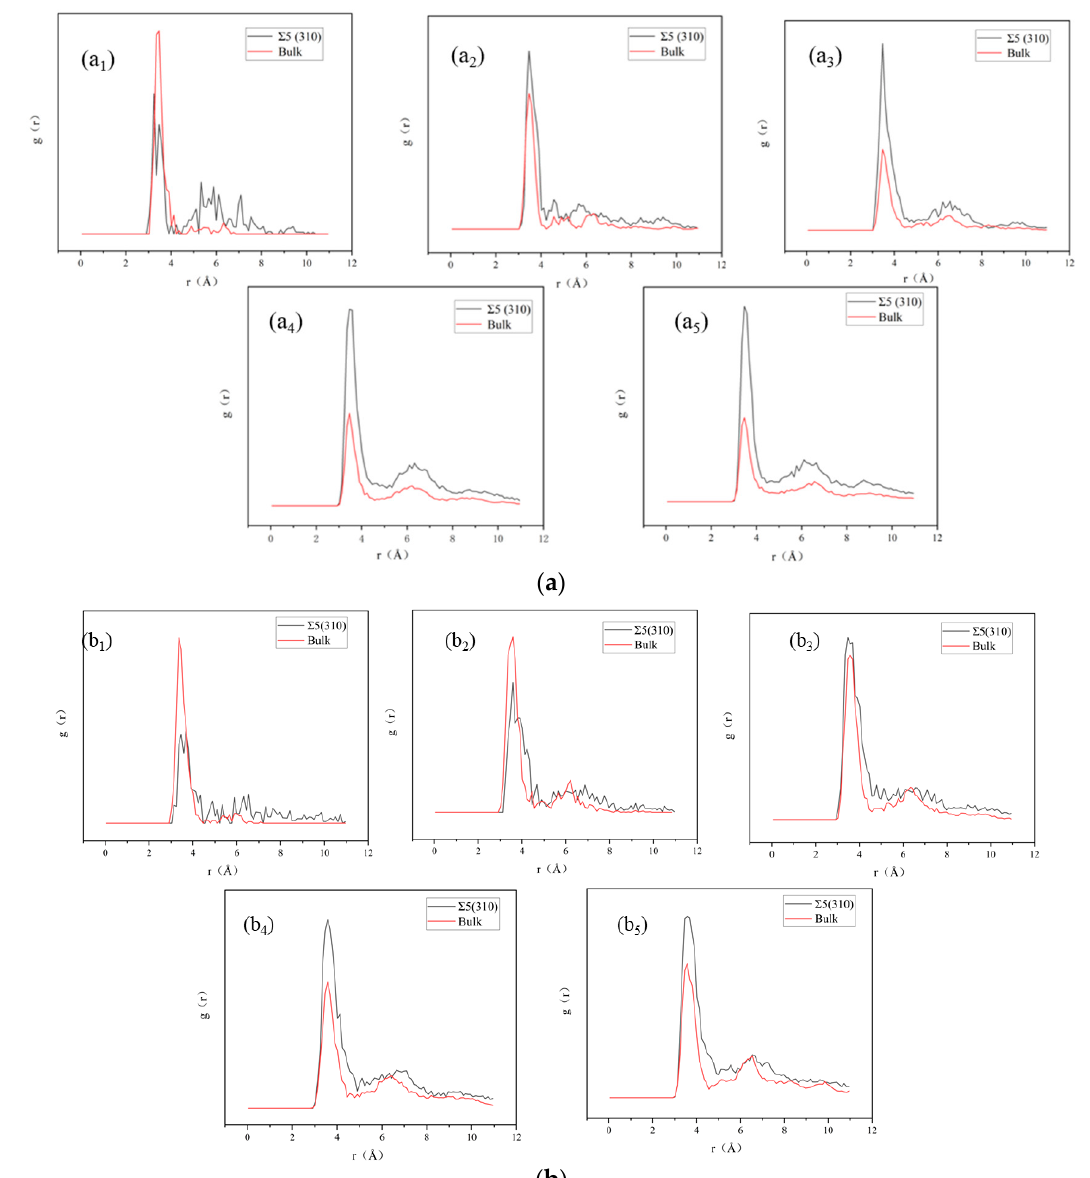
Figure 6. Radial distribution function of Xe atoms in Xe bubbles at ( a ) 1000 K and ( b ) 2000 K. The icons 1, 2, 3, 4 and 5 correspond to the number of Xe atoms 5, 10, 20, 40 and 50, respectively.